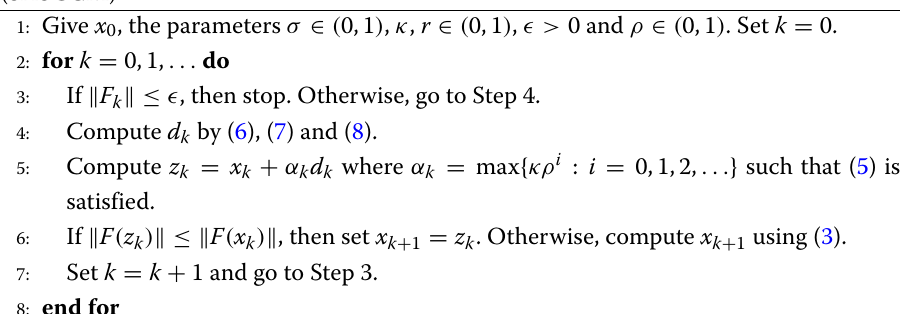
Algorithm 1 Self adaptive spectral conjugate gradient-based projection